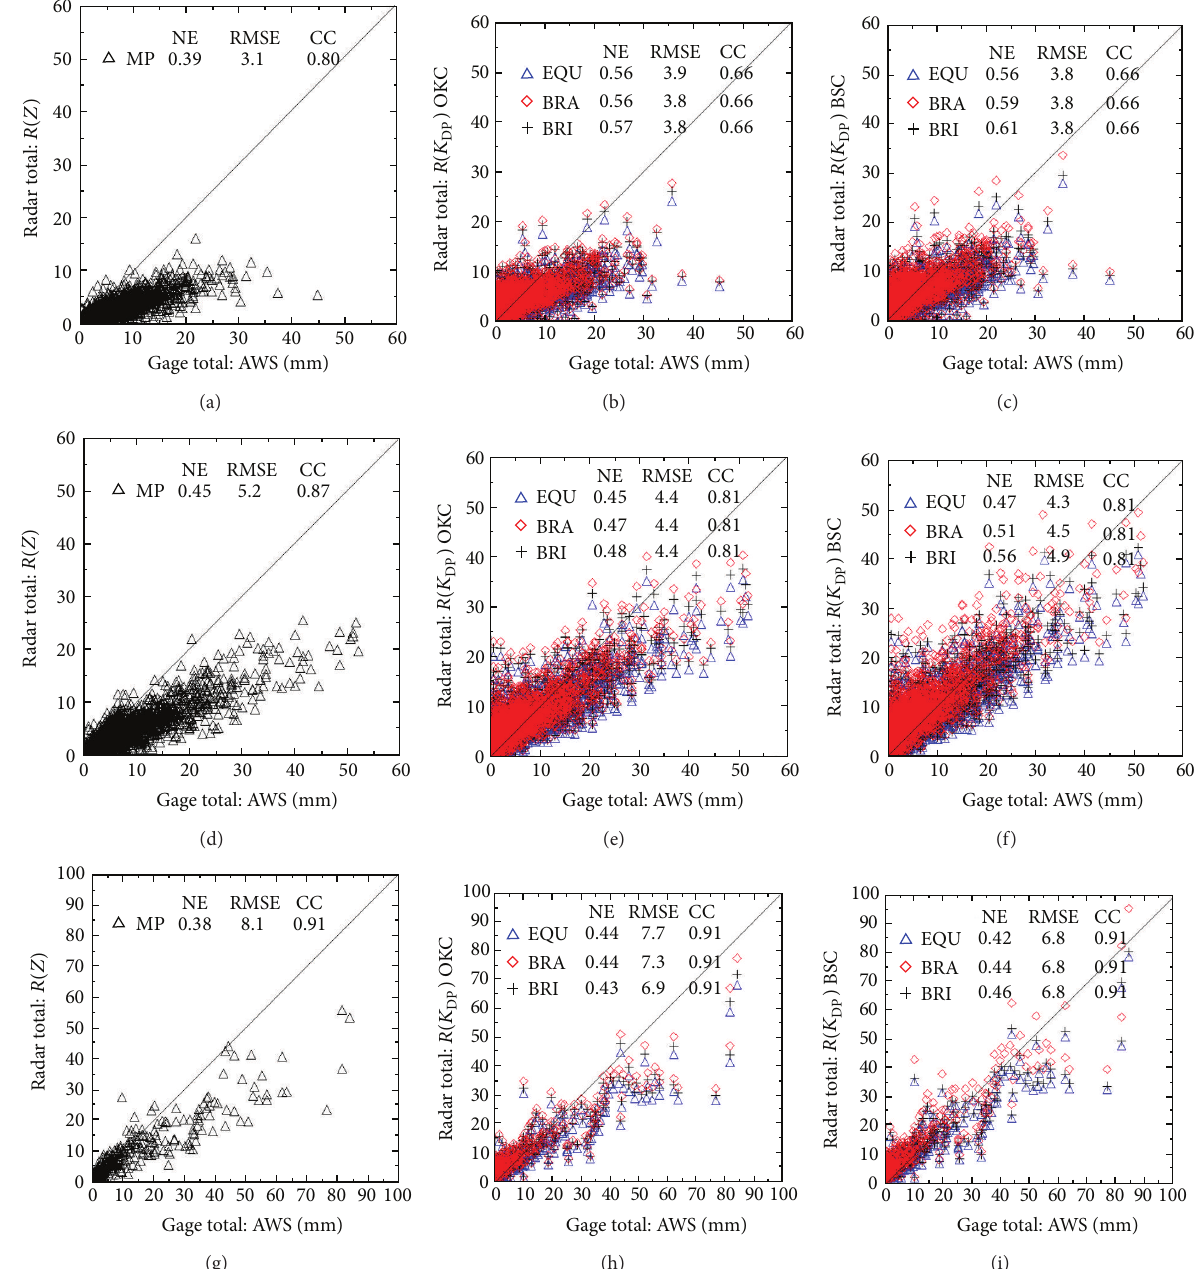
) OKC, and 𝑅(𝐾 ) BSC relations for Cases 1–3. DP DP